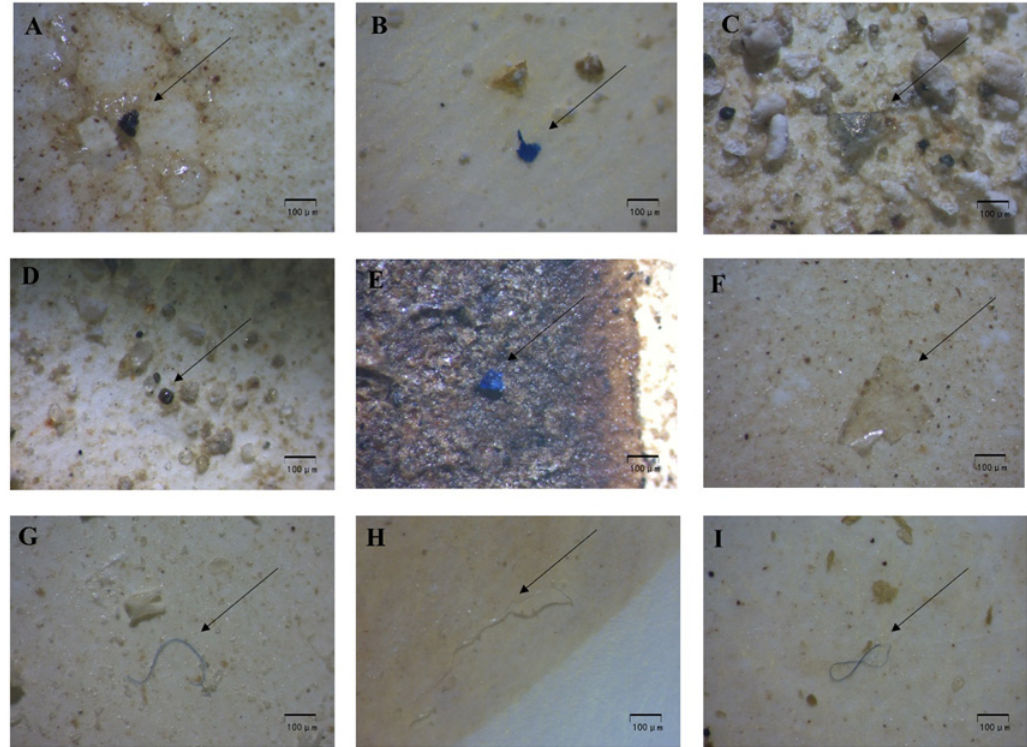
Figure 2. Shapes of microplastics in fish samples from the coastal areas of central and western Guangdong province: ( A – C ) fragments; ( D , E ) sphere; ( F )film; ( G – I ) fibers. Black arrows indicate microplastics.